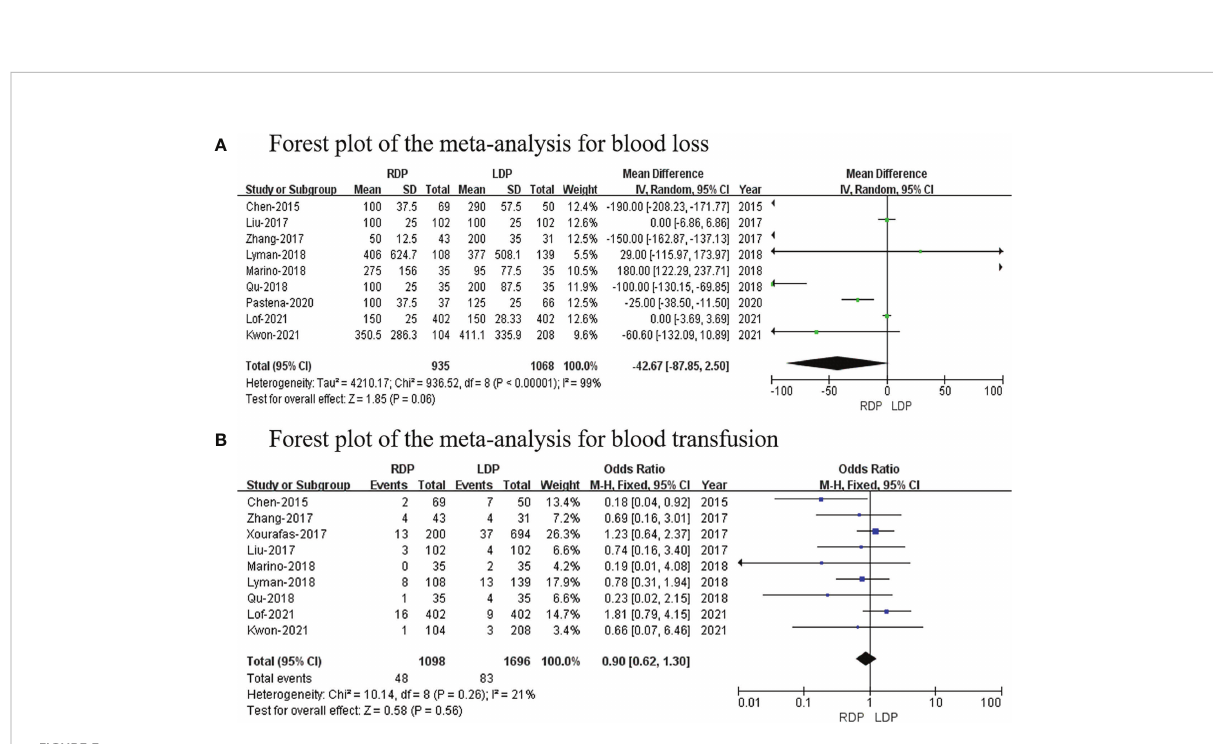
FIGURE 3 Forest plot of the meta-analysis for (A) blood loss and (B) blood transfusion.